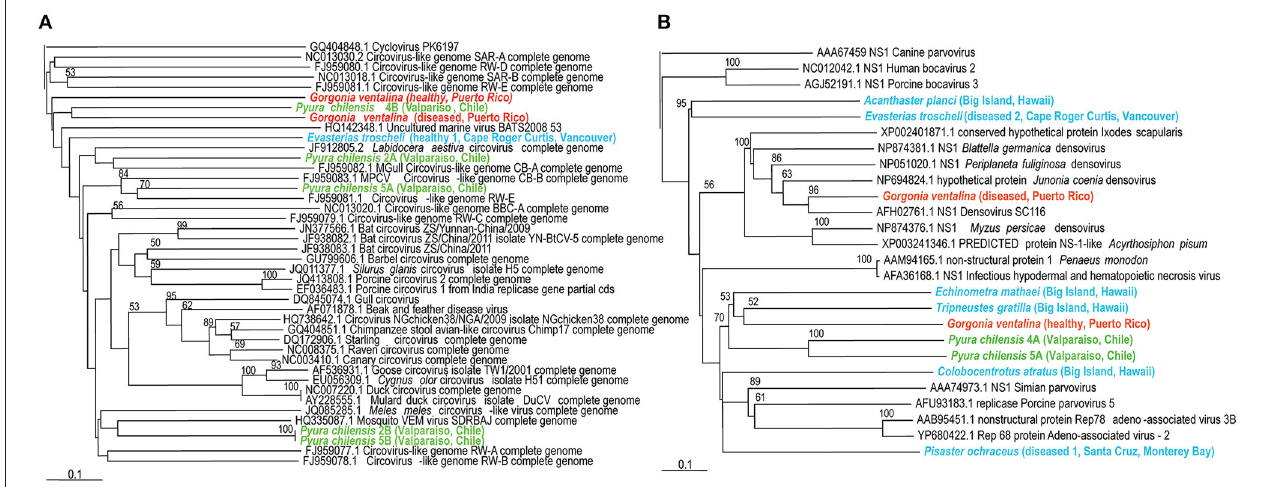
FIGURE 3 | (A, Left panel) Phylogenetic representation based on a 96 aa alignment of Circovirus replication initiator protein (rep), including closest relatives based on BLASTX comparison against the non-redundant database at the NCBI. (B, Right panel) Phylogenetic representation based on a 126 aa alignment of Densovirus non-structural protein (NS1), including closest relatives based on BLASTX comparison against the non-redundant database at the NCBI. The alignment was performed with CLUSTAL W and the tree drawn using neighbor joining. Bootstrap values of 1000 tree iterations that are > 50% are indicated at branch nodes. Scale bar represents 0.1 substitutions per site. The phyla are color-coded: blue are echinoderms, red are gorgonian octocorals, green are